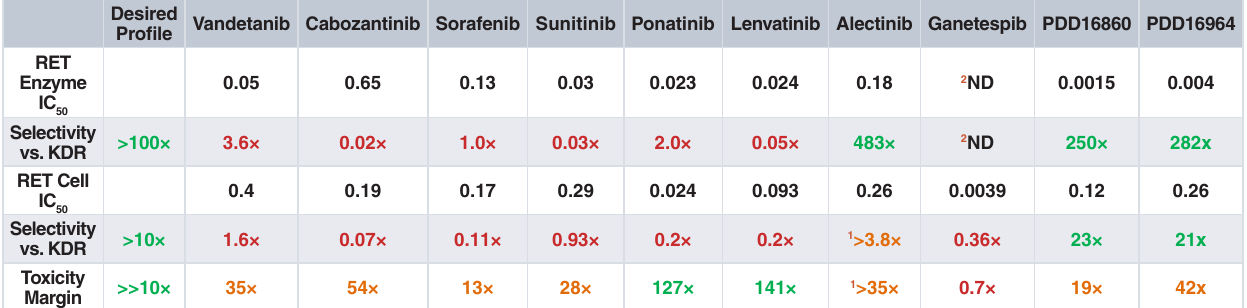
Table 1. Clinical competitor and selected compound profiling data. The desired profile values indicate our target values for selectivity and toxicity margin. All values represent the geometric mean of at least four independent measurements. Figures are highlighted depending upon whether they easily (green); clearly do not (red) or almost (orange) meet the target criteria. PDD16860 and PDD16964 are examples of QZ compounds developed by screening through the